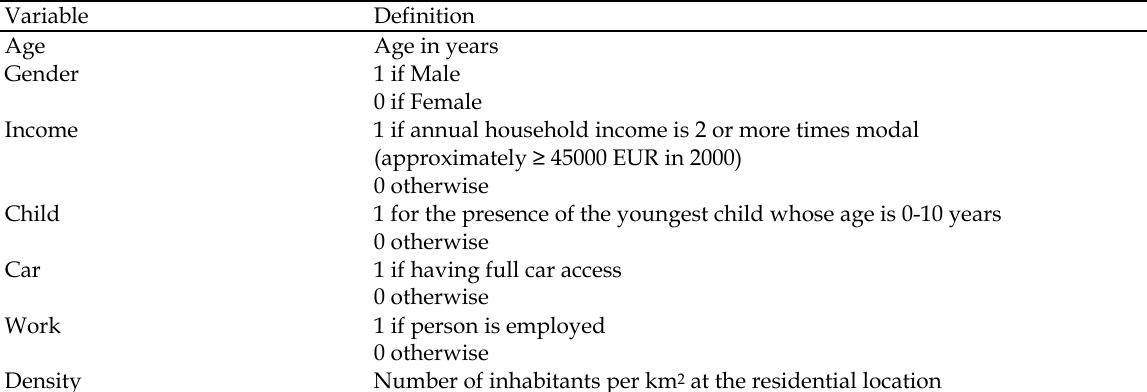
Table 2. Definition of Explanatory